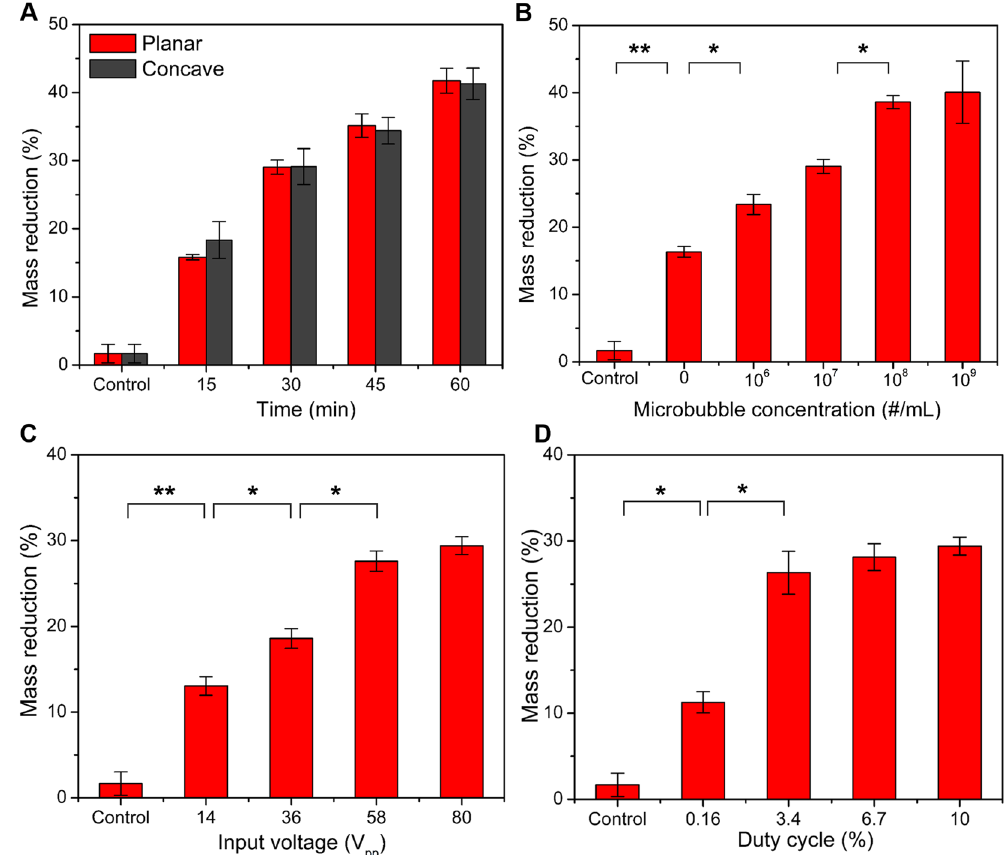
Figure 4. In vitro test results with different input parameter. ( A ) Mass reduction of the clots (200 mg ± 10%) in accordance with treatment time of 15–60 min (620 kHz operating frequency, 80 V pp input voltage, 10% duty cycle, 100 μ l/min injection of 10 7 bubbles/ml). Despite of the different pressure output ( > 100% difference) both aperture prototypes realize similar ( < 5% difference) mass reduction; the difference of mass reduction showed no statistical significance. ( B–D ) Mass reduction upon variation of treatment condition; fixed parameters for each test are 30 min treatment time, 80 V pp input voltage, 10% duty cycle (5 ms burst duration and 305 cycle- burst), 10 7 bubbles/ml injection with 100 μ l/min flow rate (n = 3). ( B ) Variation of microbubble concentration. ( C ) Variation of input voltage. ( D ) Variation of duty cycle. ( * P < 0.05, ** P <